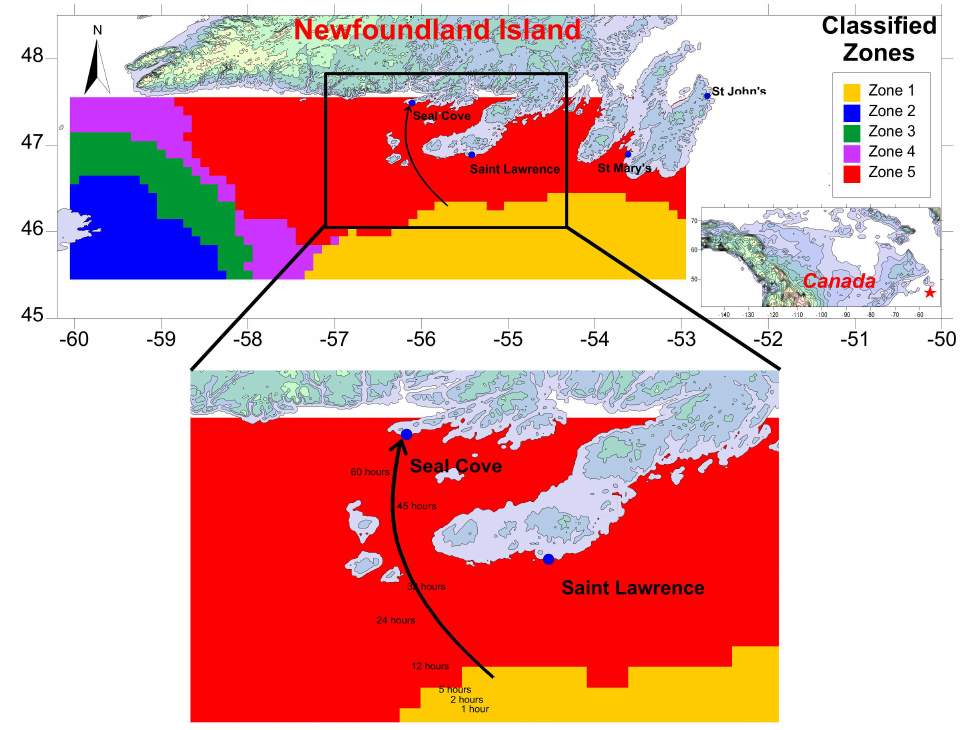
Figure 6. The movement of spilled oil in 60